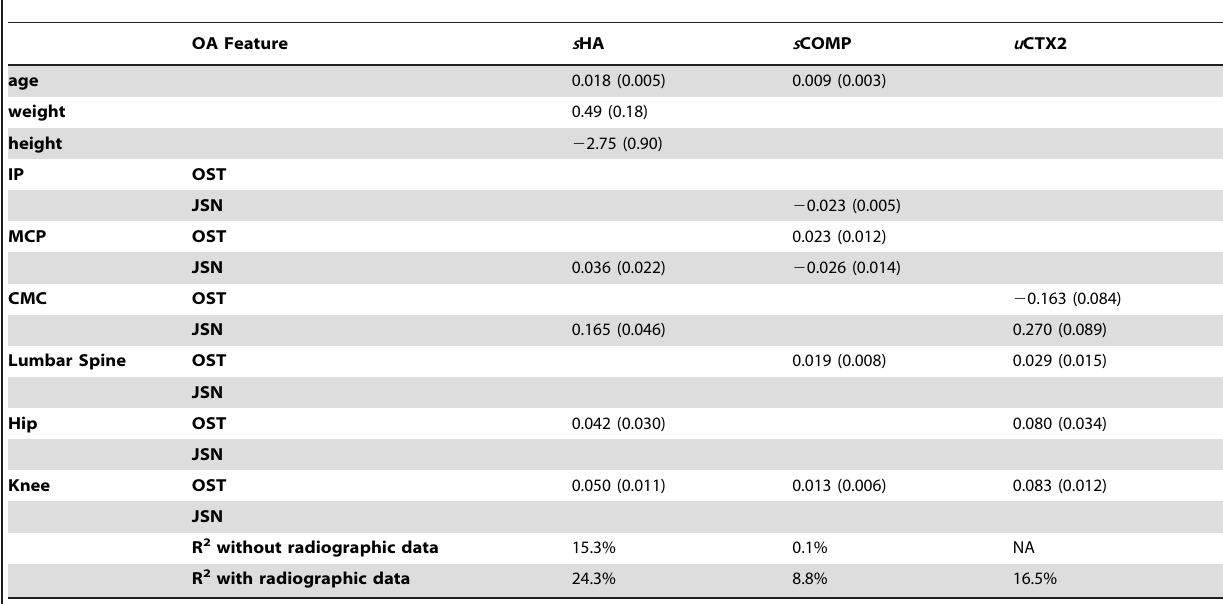
The numbers are parameter estimates with their standard errors in parentheses. AIC = Akaike’s Information Criterion. Percent biomarker variance explained (generalized R 2 ) with and without radiographic data (i.e. IP MCP, CMC, spine, hip and knee data). IP = interphalangeal (distal and proximal) finger joints. MCP = metacarpophalangeal (knuckle) hand joints. CMC = first carpometacarpal (base of thumb)